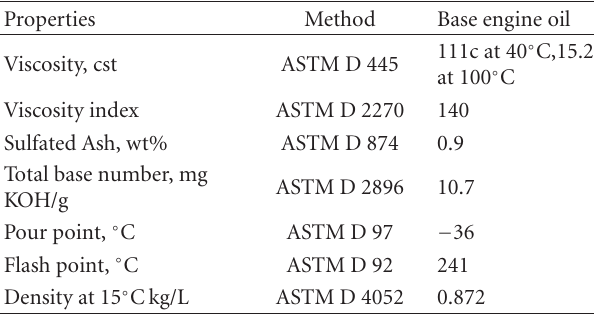
Table 2: Properties of Mobil Delvac Elite 15W-40 oil, from